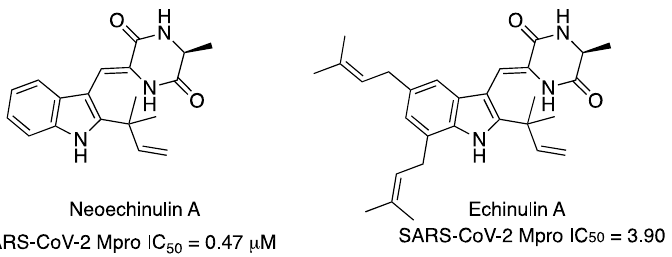
Figure 15. Marine natural products neoechinulin A and echinulin A inhibitors of SARS ‐ CoV ‐ 2 Mpro enzyme.